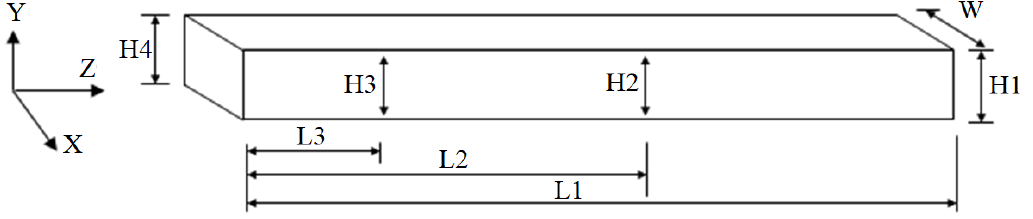
Figure 6. Parametric model used in the geometric optimization.